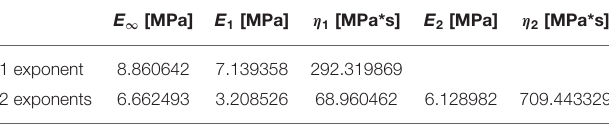
TABLE 2 | Fit parameters to estimate the viscoelasticity of a representative propolis sample using the Equation (4)